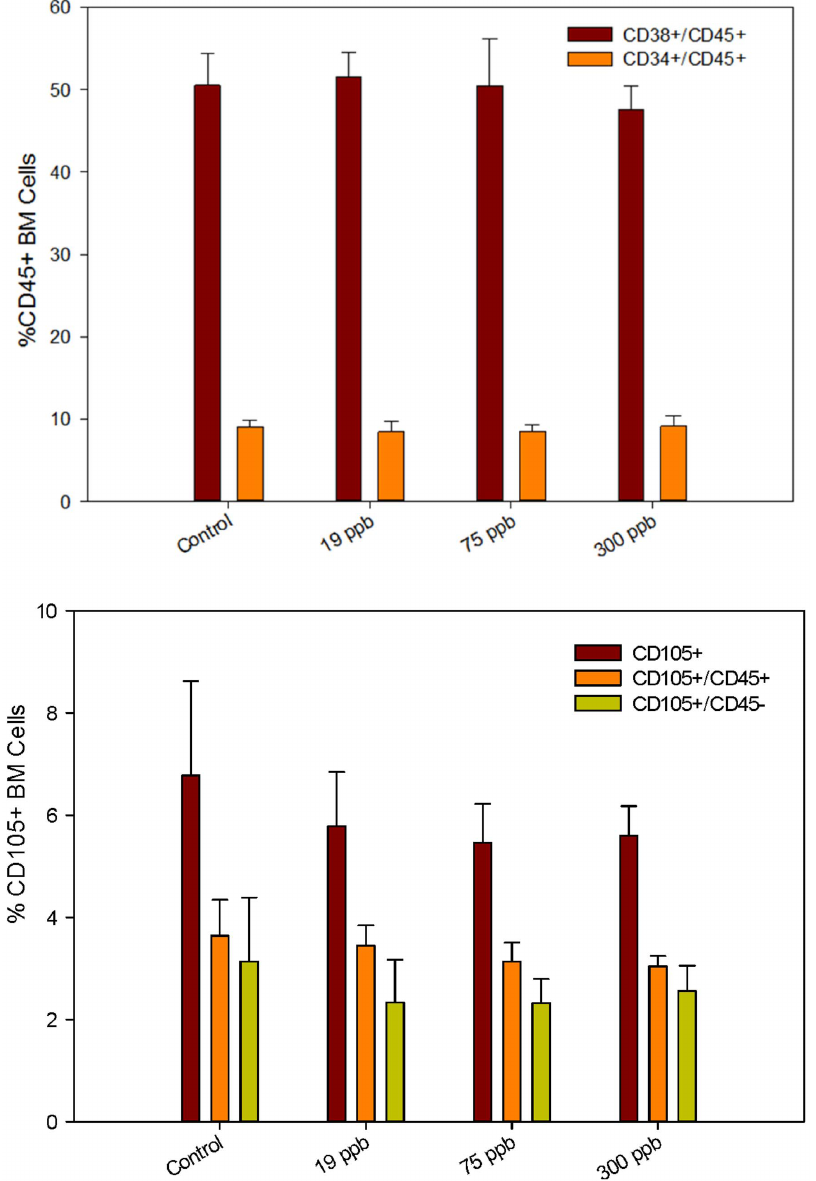
Figure 1. Bone marrow (BM) cell surface marker expression analyzed by flow cytometry. Percent CD34 + and CD38 + mice BM cells co- expressing CD45 [Top] and percent BM cells expressing CD105 [Bottom] in CD45 + and CD45- cells after 30 day consumption of As + 3 in drinking water. Results are Means + SD.